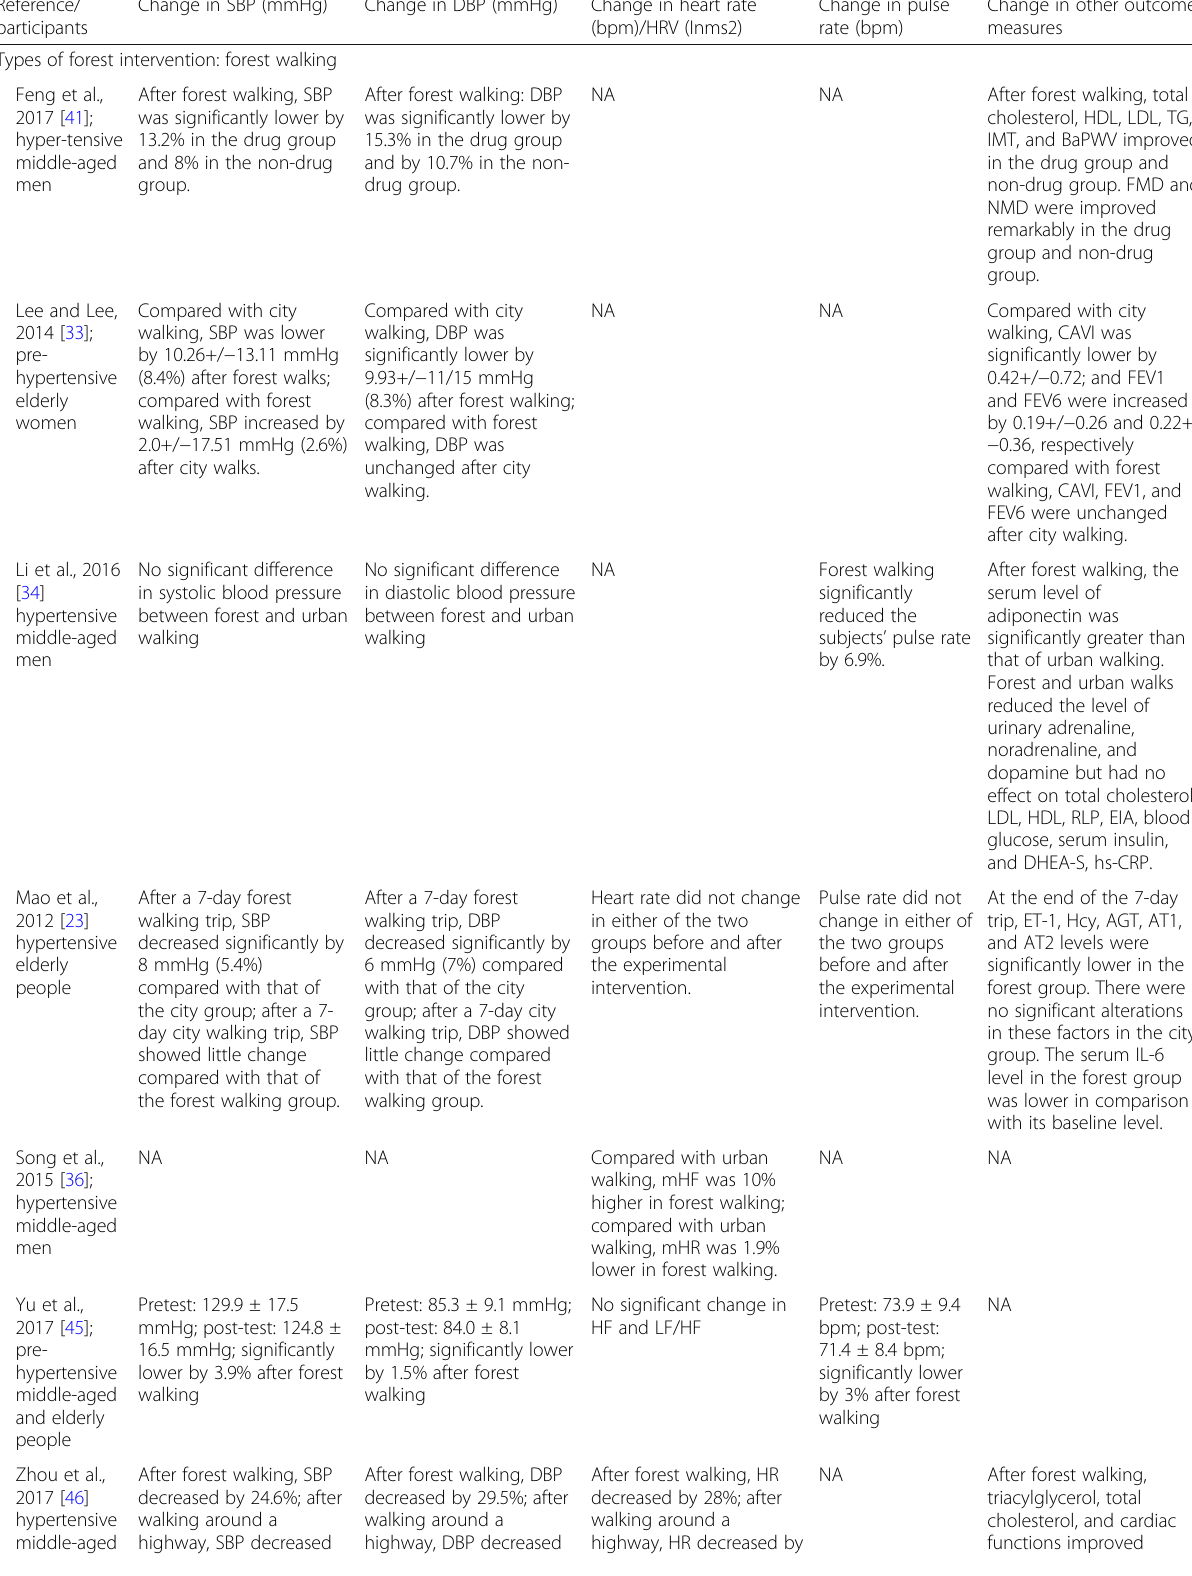
Table 2 Summary of the physiological outcome measures of the included studies Reference/ Change in SBP (mmHg) Change in DBP (mmHg) Change in heart rate participants